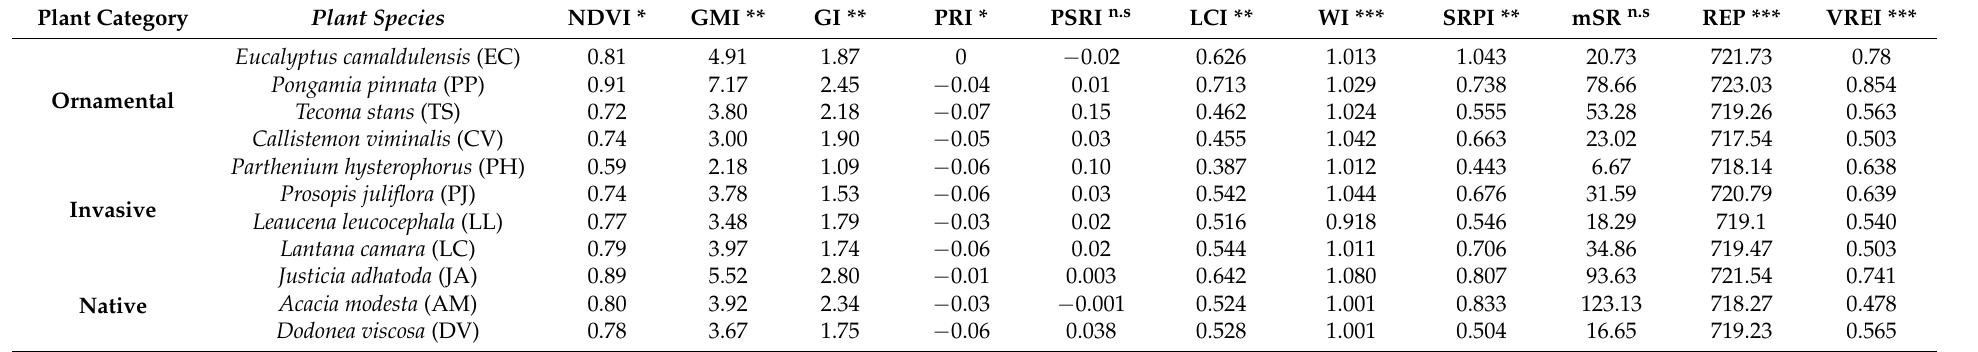
Table 3. Mean spectral indices (biophysical and biochemical parameters) of different plant